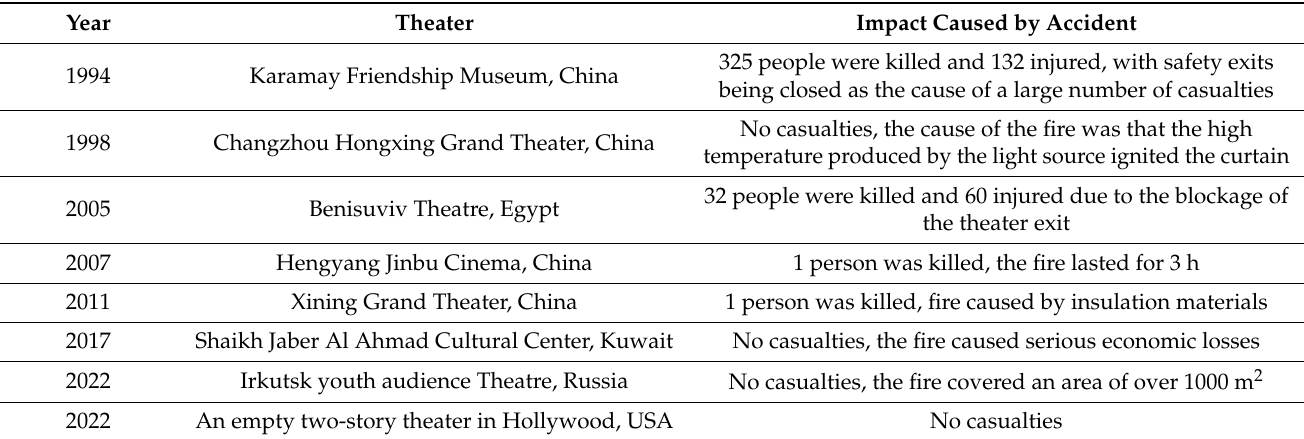
Table 1. Statistics of theater fire